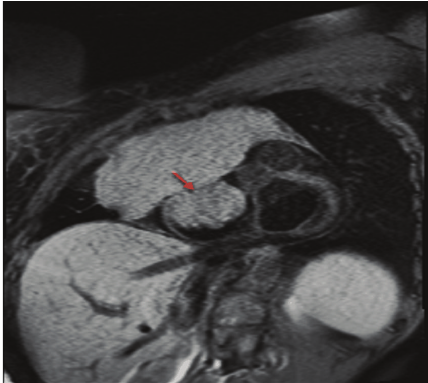
Figure 4: Cardiac MRI short axis T1 at the level of mitral valve reveals a large mediastinal mass infiltrating and obliterating the SVC causing SVC obstruction. The tumor extends into the right atrium (red arrow) and invades the tricuspid valve. Maximum diameter of the mediastinal mass measures 15×10 cm, and the mass in the right atrium measures 5.8 × 5.3